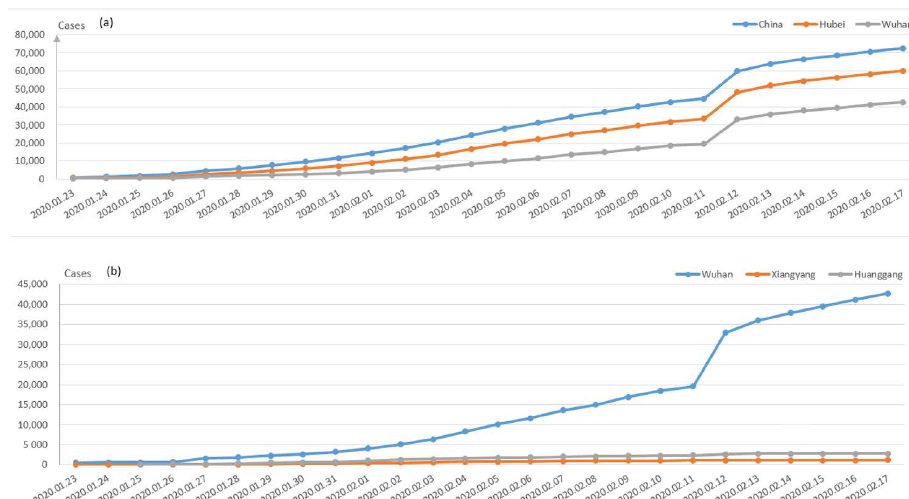
Figure 3. ( a ) Comparison of the cumulative confirmed cases of China, Hubei province and Wuhan; ( b ) comparison of the cumulative confirmed cases among three cities in Hubei province: Wuhan, Xiangyang and